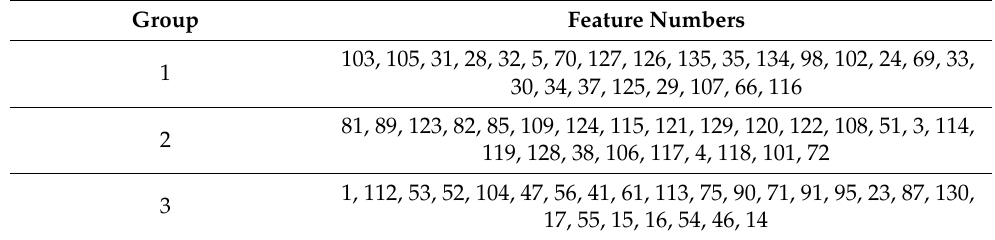
Table 6. Top 75 features according to the Relieff method.